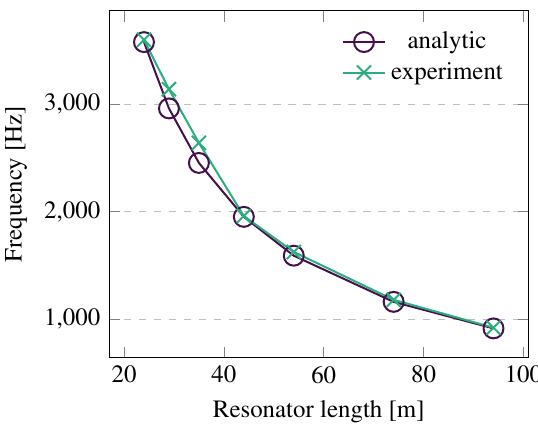
Fig. 4. Measured frequencies and analytically obtained values .